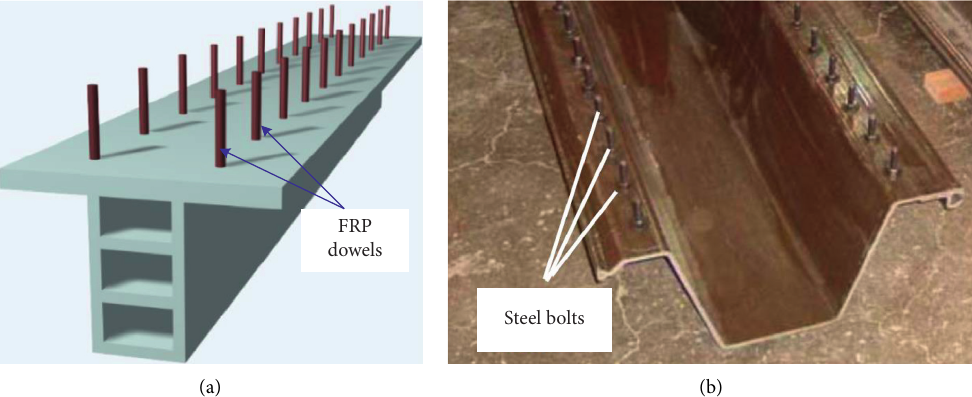
Figure 20: Overview sand coating connection type. (a) FRP dowels. (b) Steel